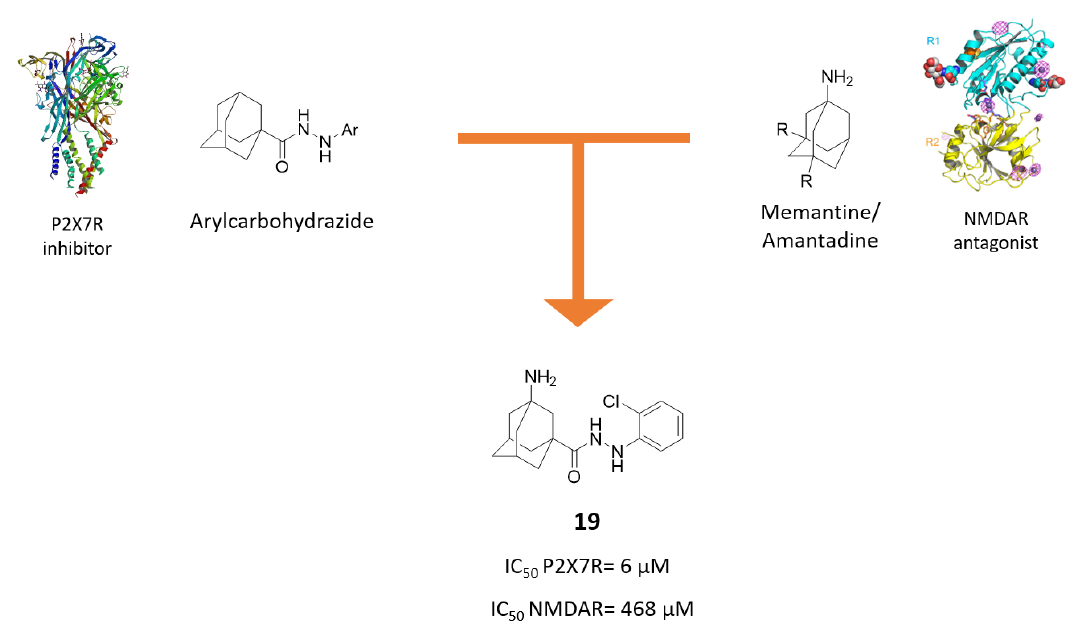
Figure 12. Drug design and biological activities of N’-arylcarbohydrazide-aminoadamantane hybrid 19 .